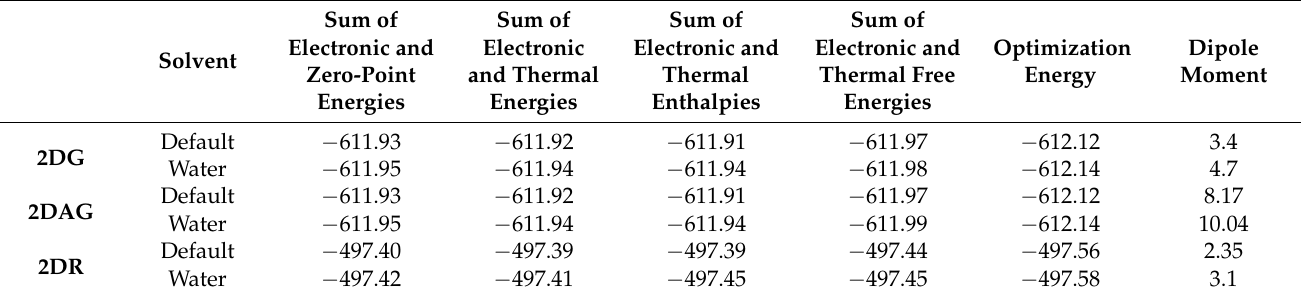
Table 1. Various thermodynamic parameters of 2DG, 2DAG and